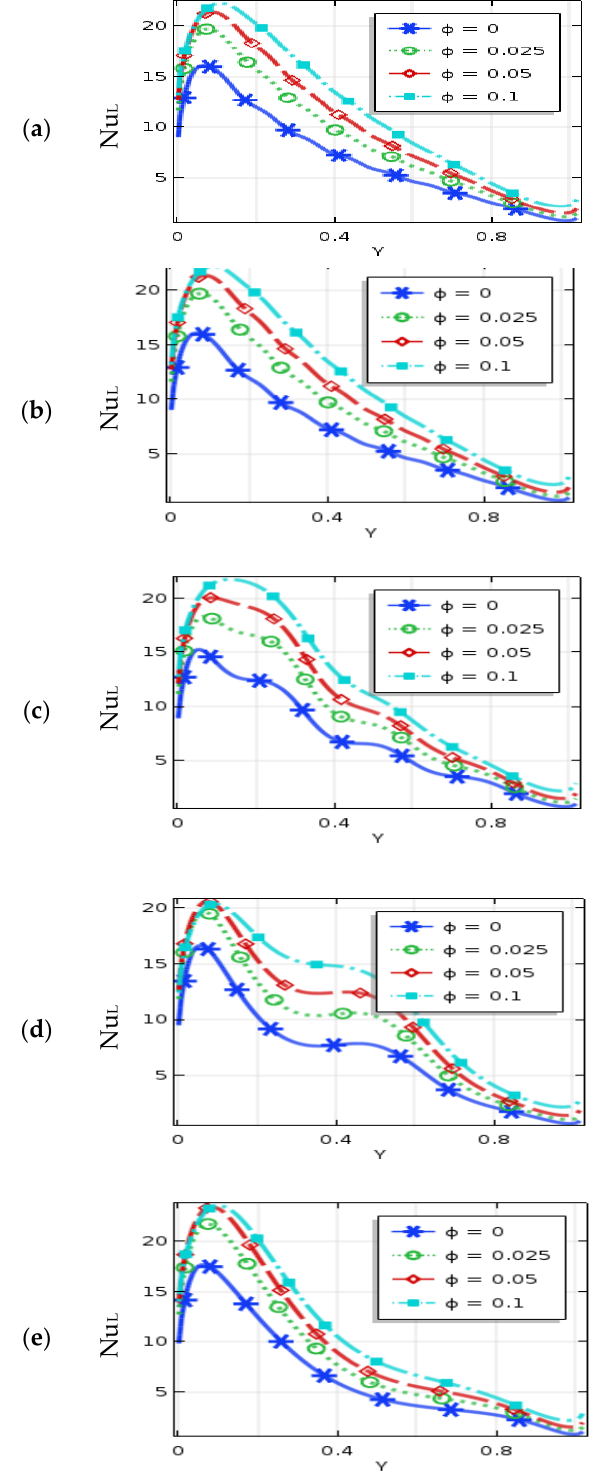
Figure 9. Local Nusselt number for nanoparticles volume ( φ ), and ( a ) umf, ( b ) λ = 0.1, ( c ) λ = 0.25, ( d ) λ = 0.5, and ( e ) λ = 1 when Ra = 10 6 , Ha = 30, d = 10 nm, n = 3, and τ = 1.